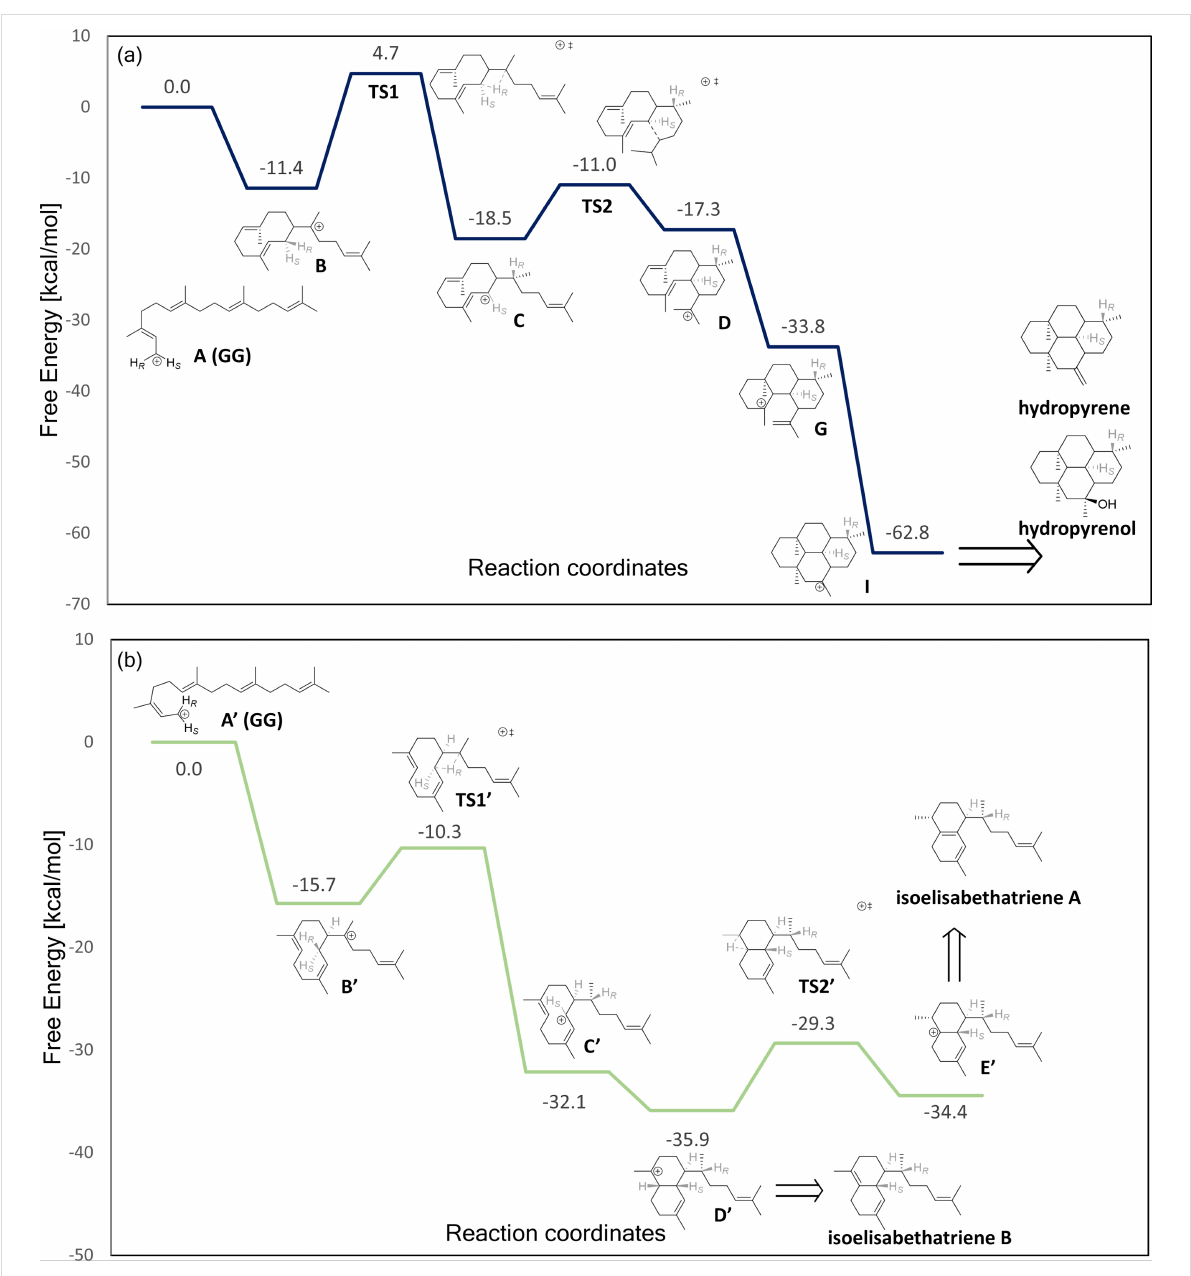
Figure 2: Free energy profile of hydropyrene cation (a), and IE cation (b) formation in the gas phase. The free energy of cation A and A’ is set to zero. Bonds breaking/forming in the transition states are marked by dotted lines. All calculations were performed in the gas phase at the M06-2X/6- 31G+(d,p) level of